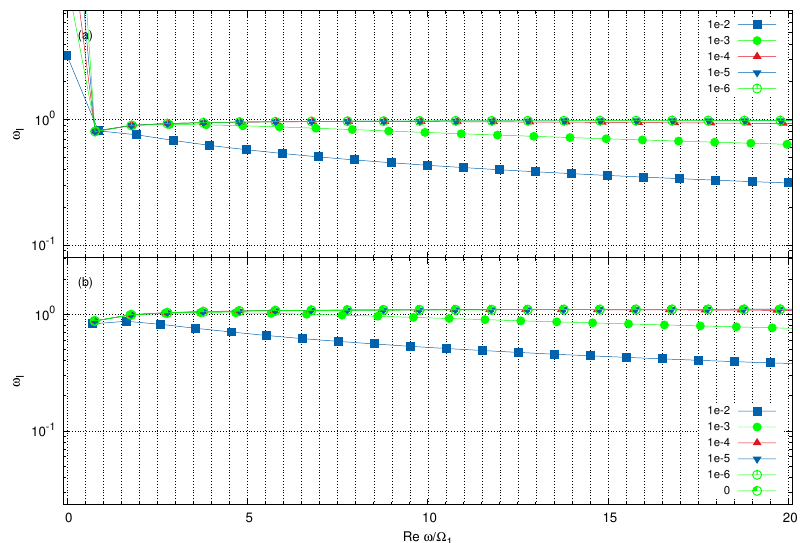
Fig. 4. Eigen-frequencies (Re ω/ Ω 1 , ω I ) of l = 2 (a) and l = 3 (b) for series q = − 1 and different values of parameter L T